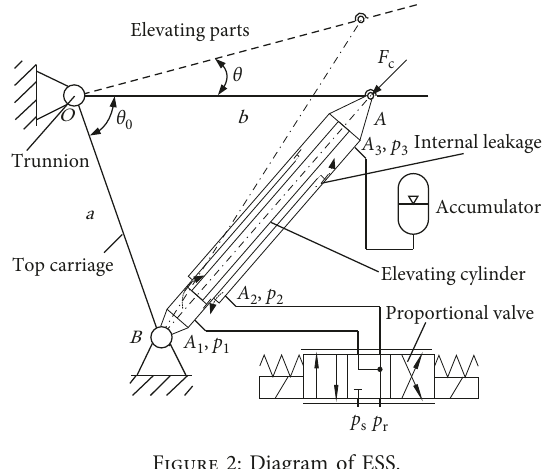
Figure 2: Diagram of